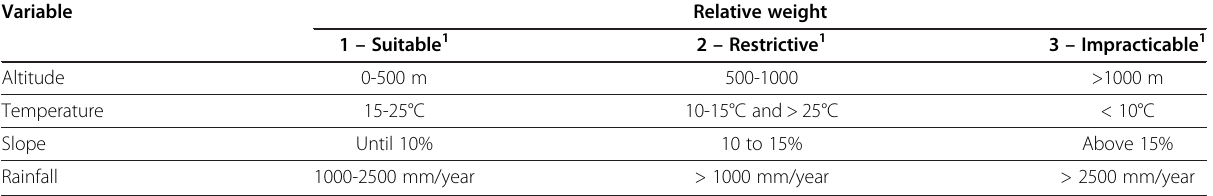
Table 1 Attributes and their relative weights according to the potential risk of fasciolosis in Espírito Santo state, Brazil Variable